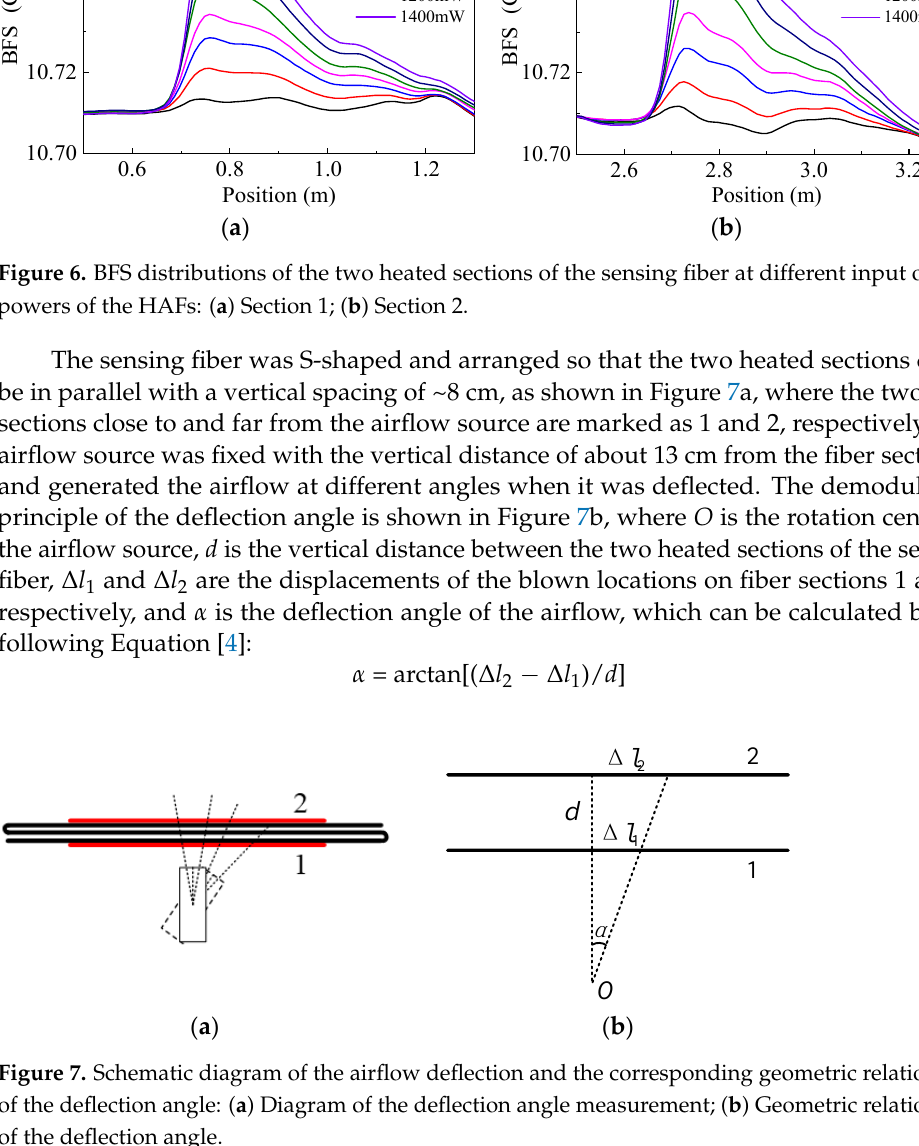
( b ) Figure 8. Measurement results of airflow direction: ( a ) BFS distributions of the sensing fiber at dif- ferent deflection angles of the airflow; ( b ) Dip displacement vs. deflection angle for fiber sections 1 (black) and 2 (red), respectively.